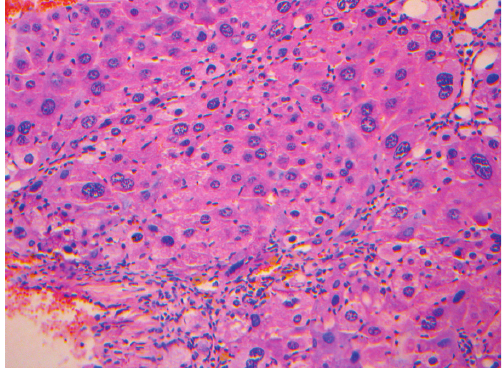
Figure 5: The pathological stage of the 13th–14th week is S4. The figure was the general appearance of liver pathology under the microscope: fibroblasts in the portal area showed evident hyperpla- sia, the fibrous septum was widened, the grid division was formed in liver cells, the pseudo-lobule of the liver was formed, and a typical liver fibrosis was formed, which indicated it was at the stage of hepatic cirrhosis. HE. Bar 5200